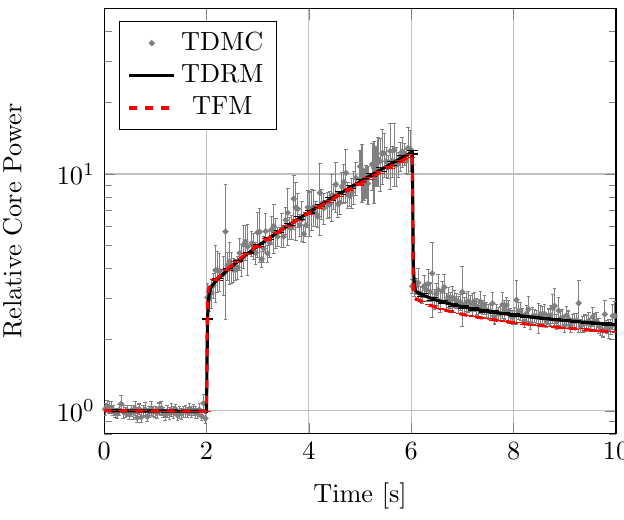
Figure 2: Evolution of relative core power during the absorber bank withdrawal